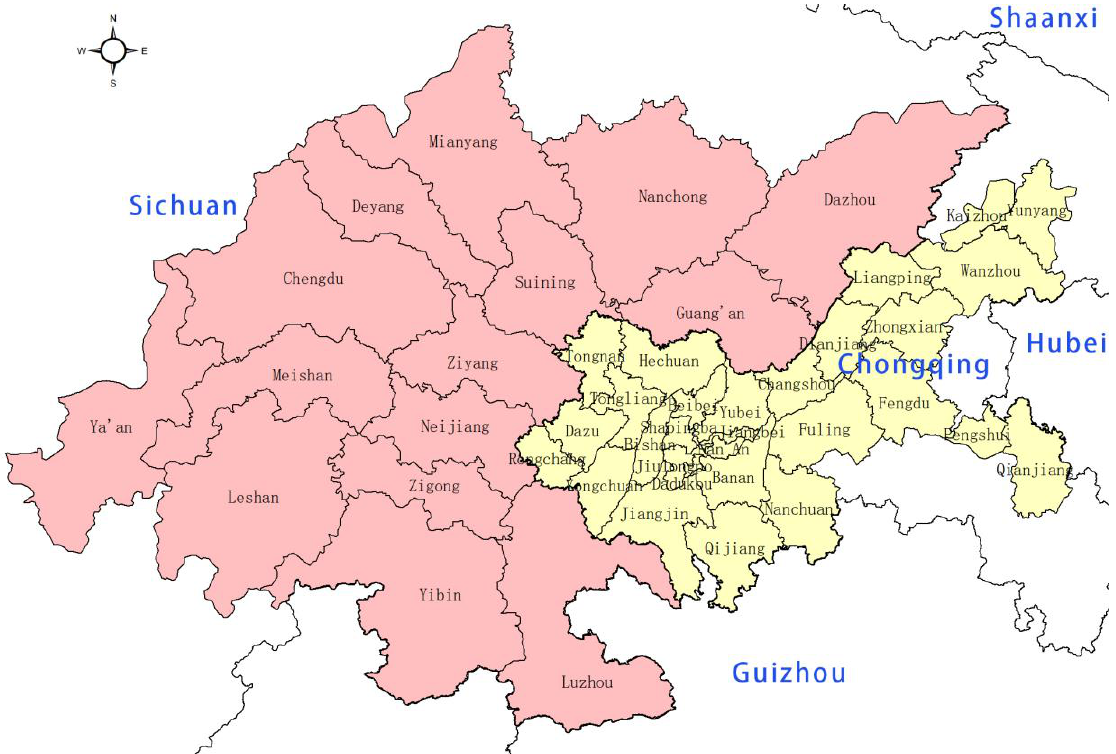
Figure 1. Map of the Chengdu – Chongqing Economic Circle.